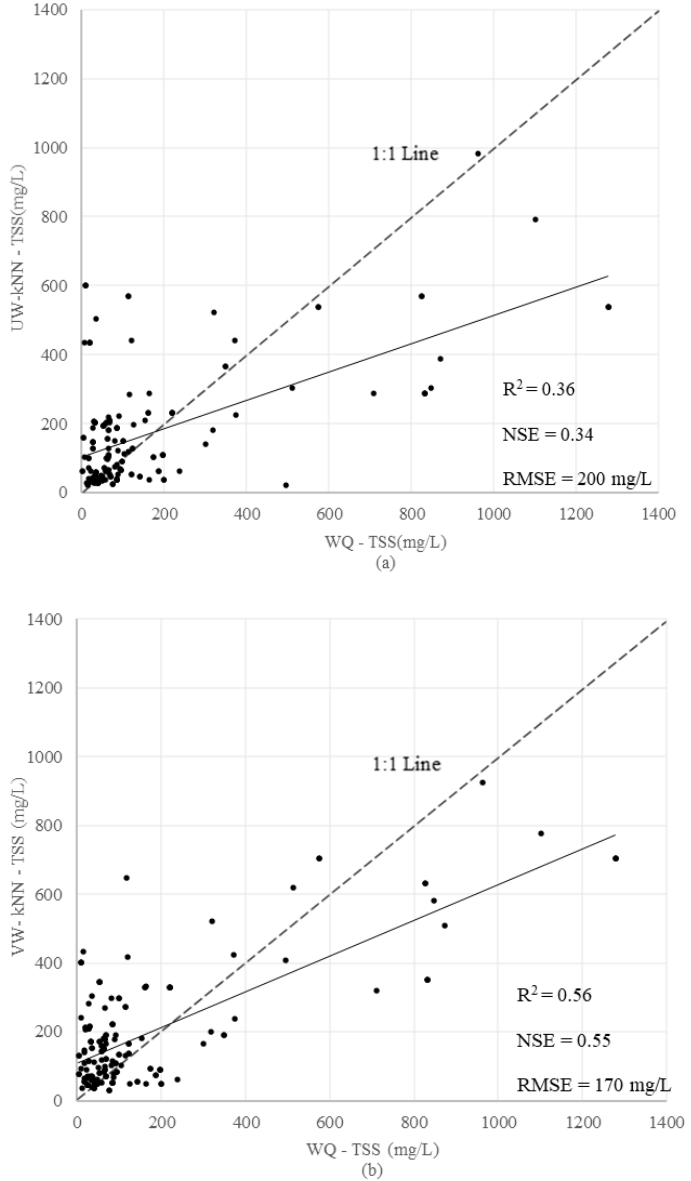
Figure 4. Correlation between the measured values and predicted TSS in the prediction step for ( a ) UW-kNN and ( b ) VW-kNN.